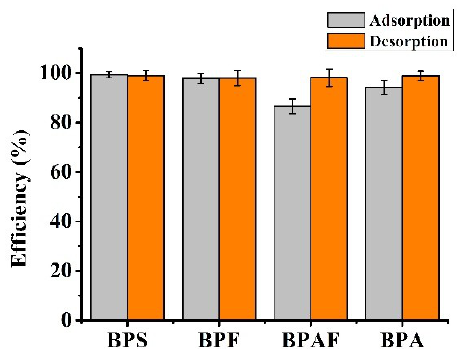
Figure 8. The enrichment performance of BPA, BPS, BPF, and BPAF on Fe 3 O 4 @CTS/SiO 2 -C 12 composite. 50 mg adsorbents in 10.0 mL solution (each 0.5 mg/L); 34 mmol/L PBS, pH 6.0; 25 ◦ C.